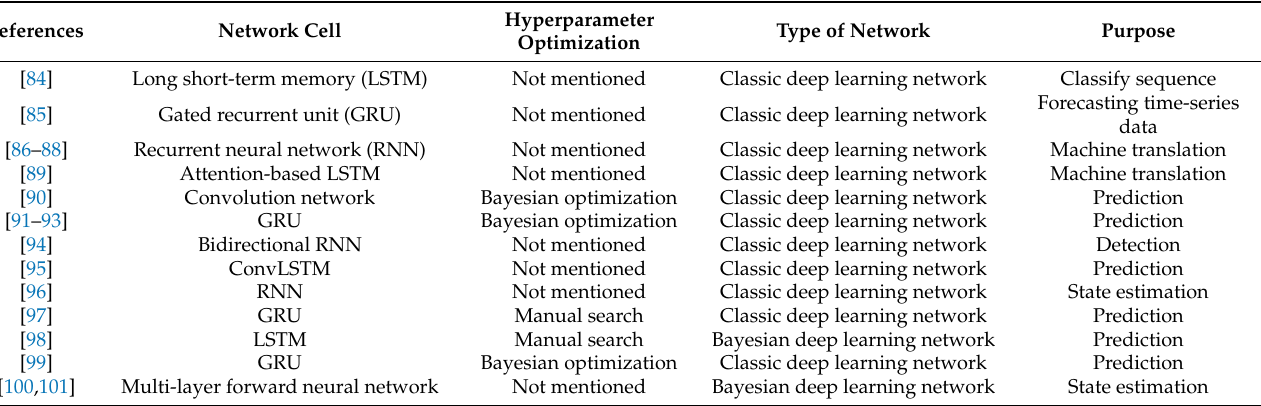
Table 2. Data-driven modeling methods with deep learning